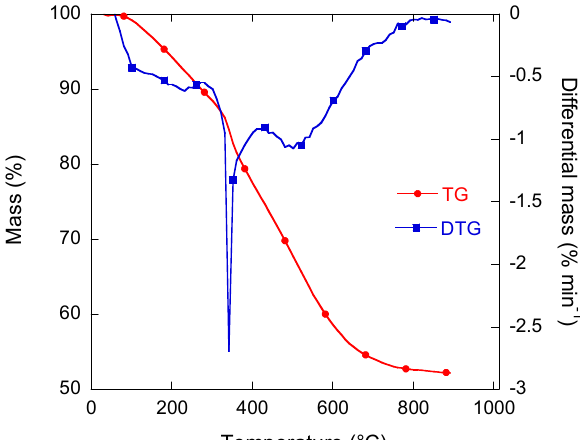
Figure 3. Mass thermogravimetry (TG) and differential mass thermogravimetry (DTG) curves of organic RF350 porous monolith.